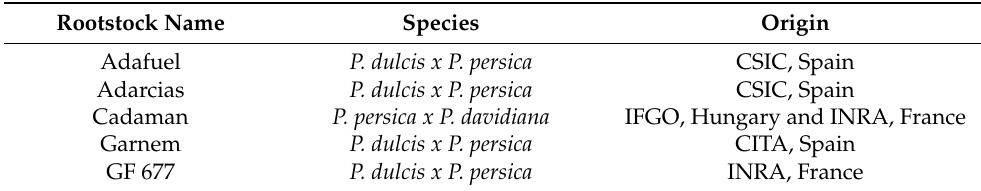
Table 1. Prunus rootstocks used in this